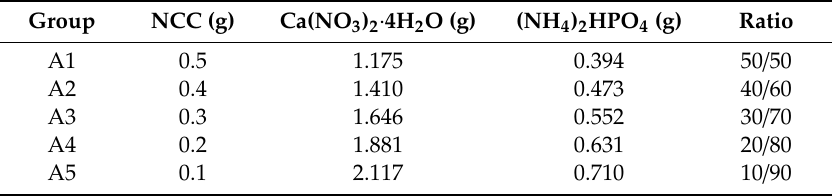
Table 1. Chemical composition ratio for NCC / HAP